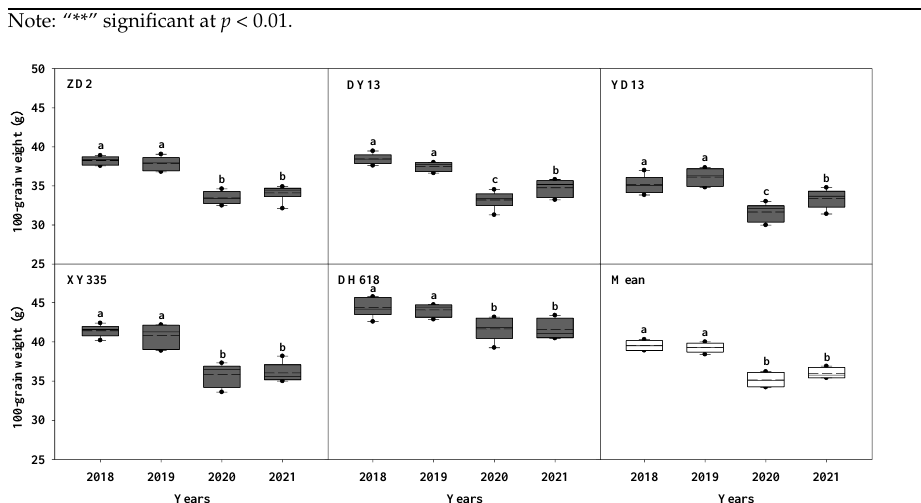
Table 2. ANOVA results for the 100-grain weight measured between the growing year and hybrids. Source of Variation DF 100-Grain Weight (F-Value) Years (Y) 3 150.30 ** 280.48 ** Y × H 12 3.19 ** Error MS 100 1.19 Note: “**” significant at p < 0.01.